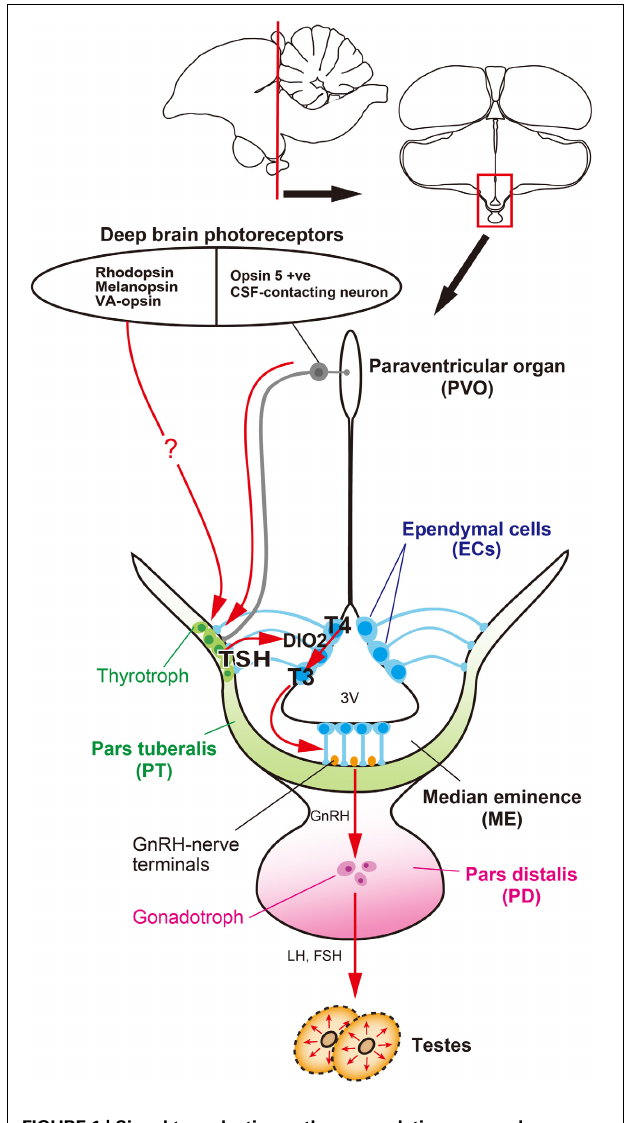
FIGURE 1 | Signal transduction pathway regulating seasonal reproduction in birds. Light information received by deep brain photoreceptors is transmitted to the pars tuberalis (PT) of the pituitary gland, a regulatory hub for seasonal reproduction. Long day-induced thyrotropin (TSH) in the PT acts on ependymal cells to induce a thyroid hormone-activating enzyme, DIO2. The bioactive thyroid hormone, T 3 is converted by DIO2 from the prohormone, T 4 . T 3 regulates seasonal morphological changes in GnRH nerve terminals and glial processes, thereby regulating or modulating GnRH